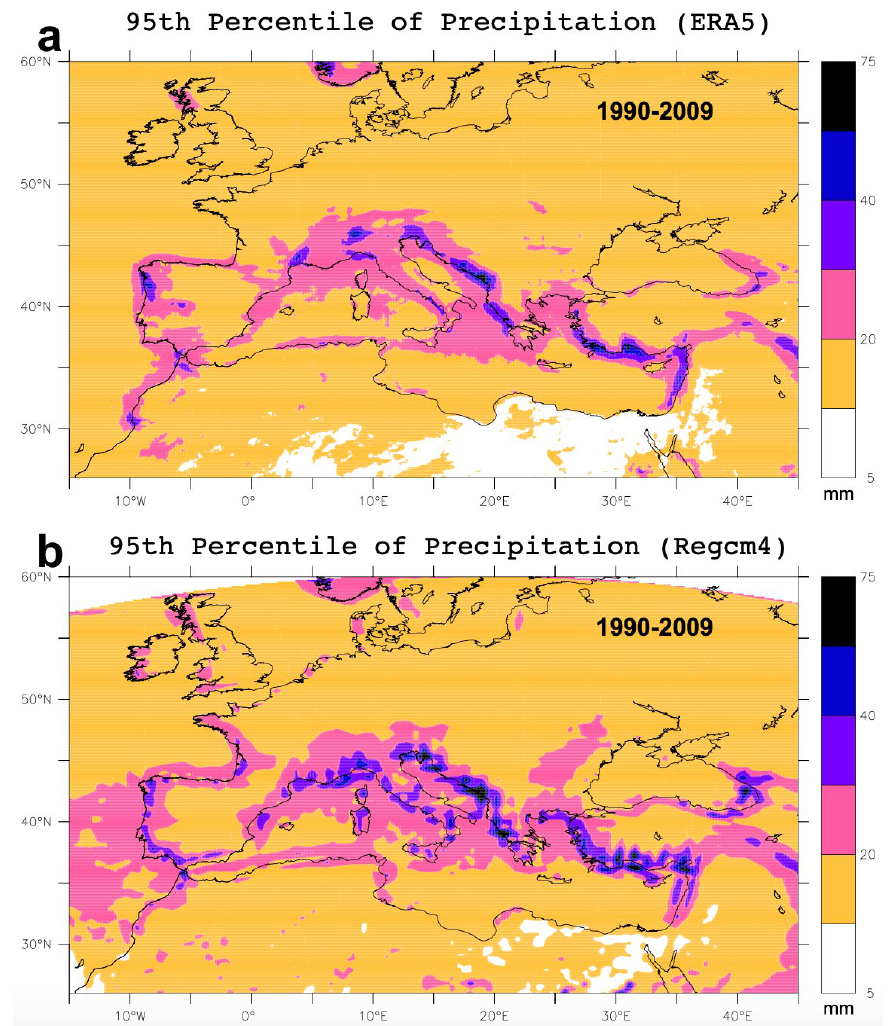
Figure 2. 95th percentile of precipitation for ( a ) ERA5 and ( b ) RegCM4 for 1990–2009.